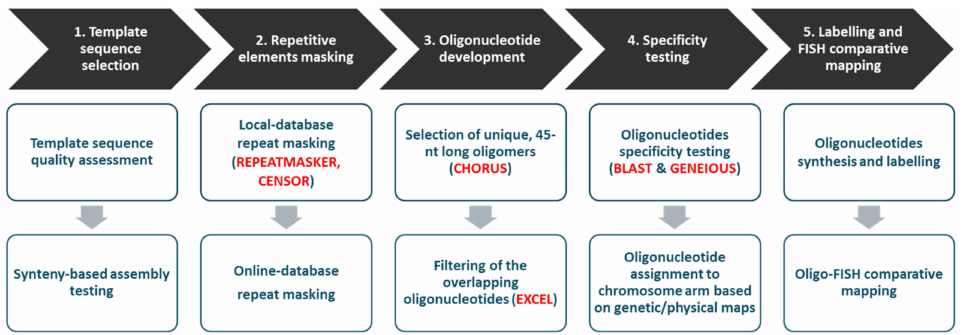
Figure 1. General scheme of oligonucleotide-based probe